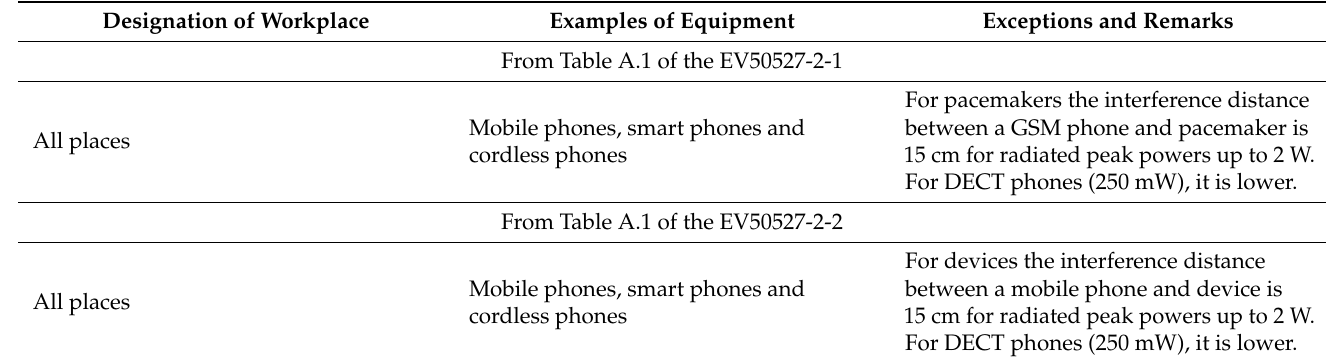
Table 5. Extract from Table A.1 of the EN50527-2-1 [14] (upper panel) and EN50527-2-2 [15] (lower panel) standards, showing the specific indications for UMTS and LTE mobile